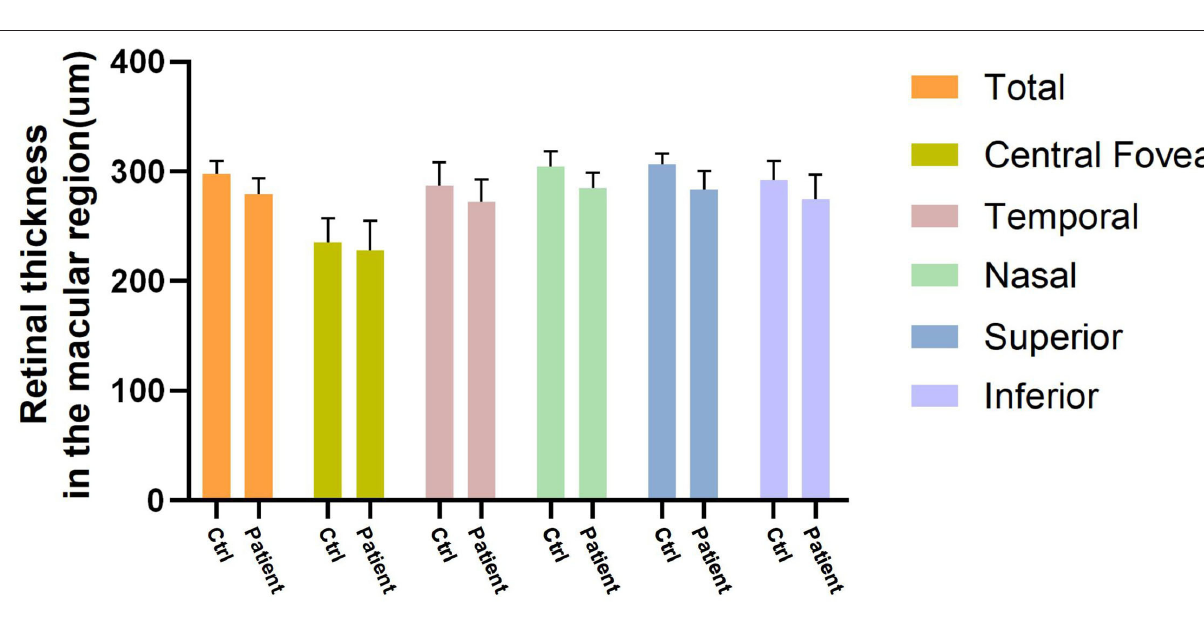
thickness were reduced in the temporal quadrant, and the correlations between these changes and other systemic indexes were further analyzed.